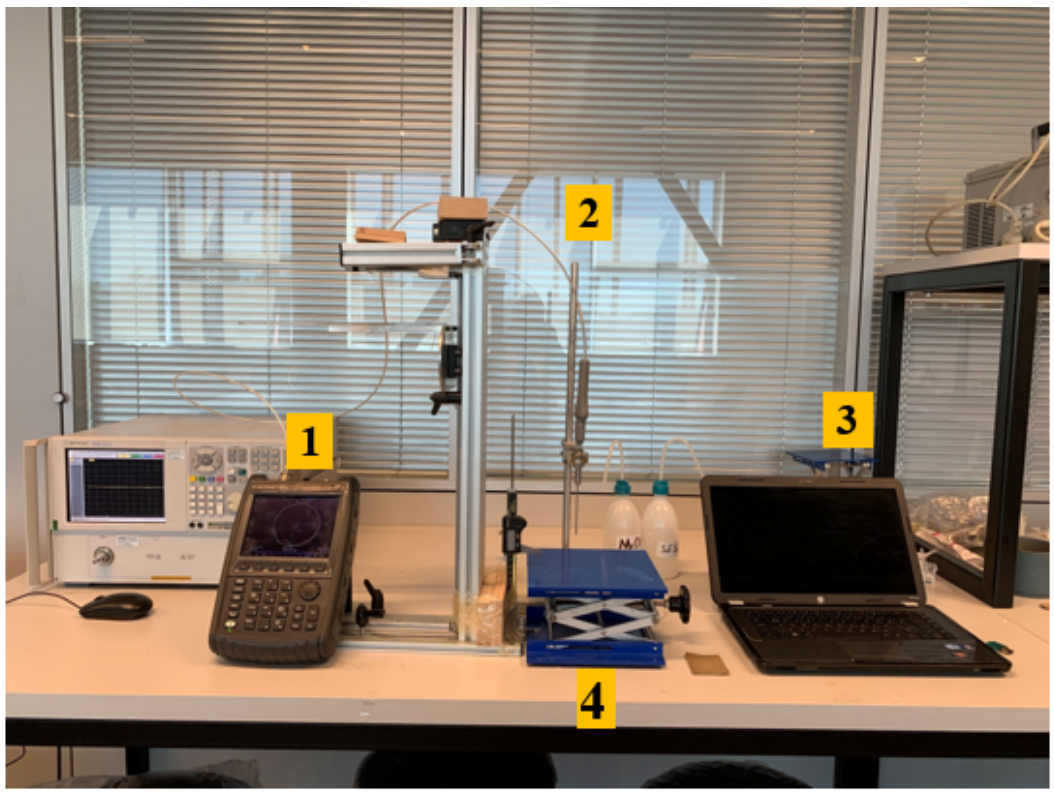
Figure 4. Experimental setup includes (1) Agilent FieldFox N9923A 6GHz RF Vector Network Analyzer (VNA), (2) Agilent Dielectric Slim Form open-ended coaxial probe, (3) Agilent 85070E software, external computer, (4) an adjustable stand and a digital